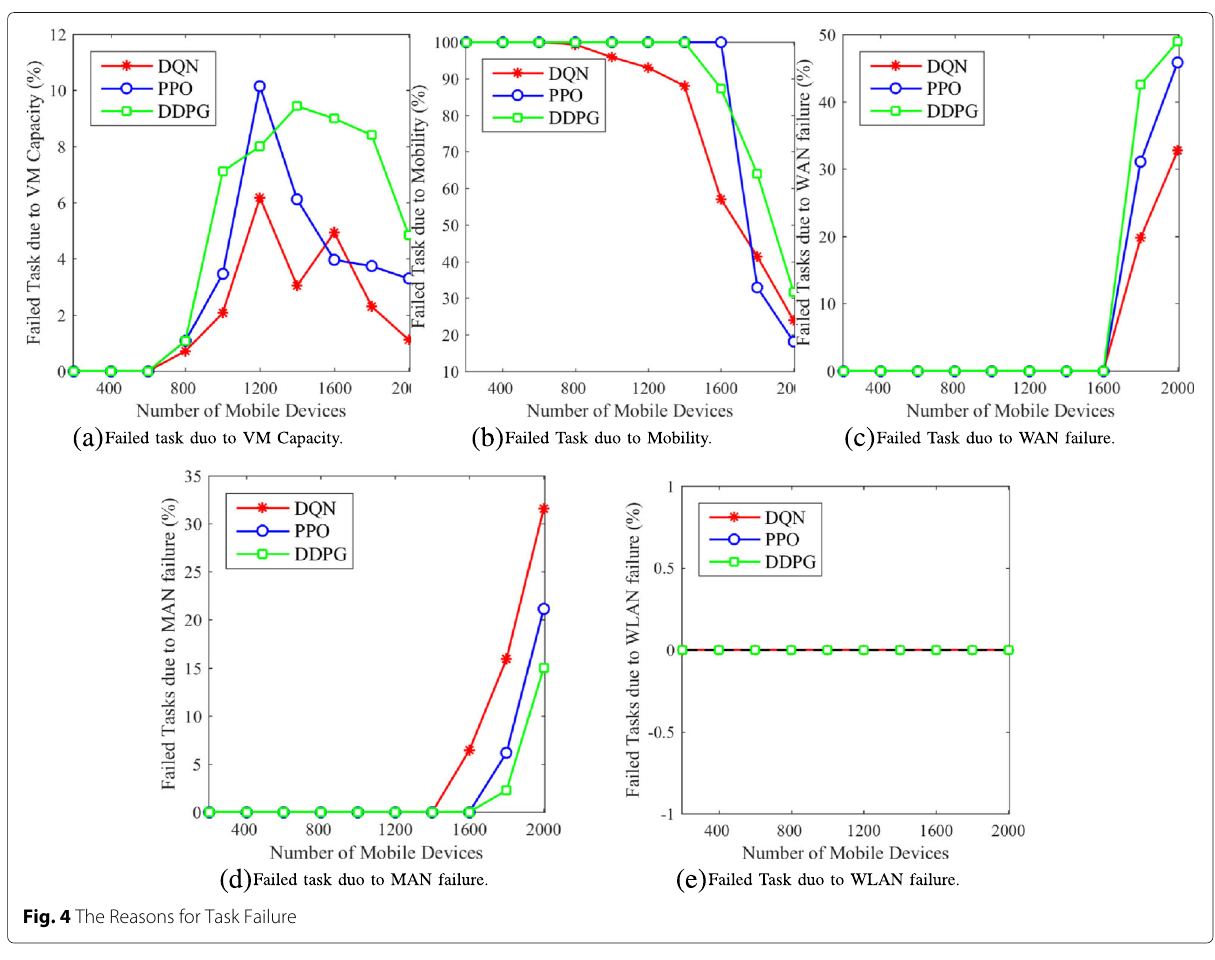
Fig. 4 The Reasons for Task Failure